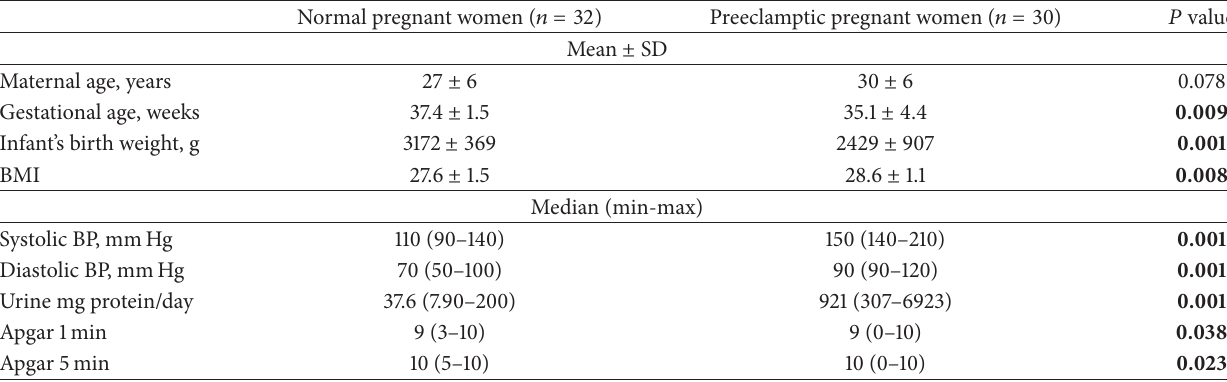
Table 1: Demographic and clinical data of the study subjects.